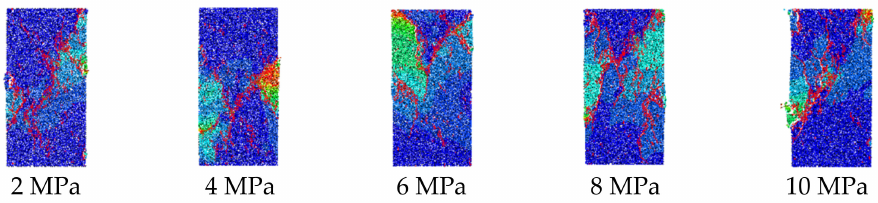
Figure 14. Crack diagrams of the clay-cement grout slurry under different curing pressures.